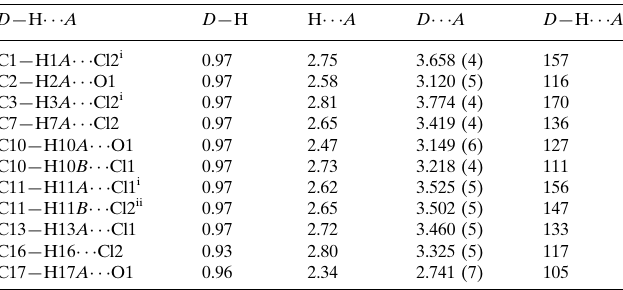
Hydrogen-bond geometry (A˚ , (cid:3)